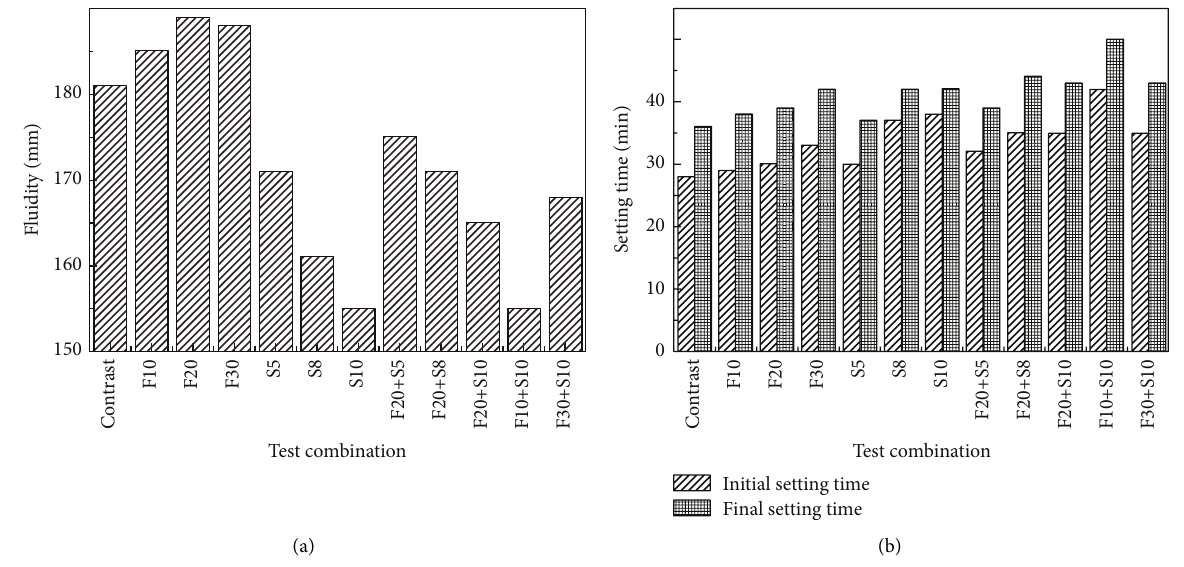
Figure 15: Effect of cement-based materials. Flowability (a) and setting time (b)